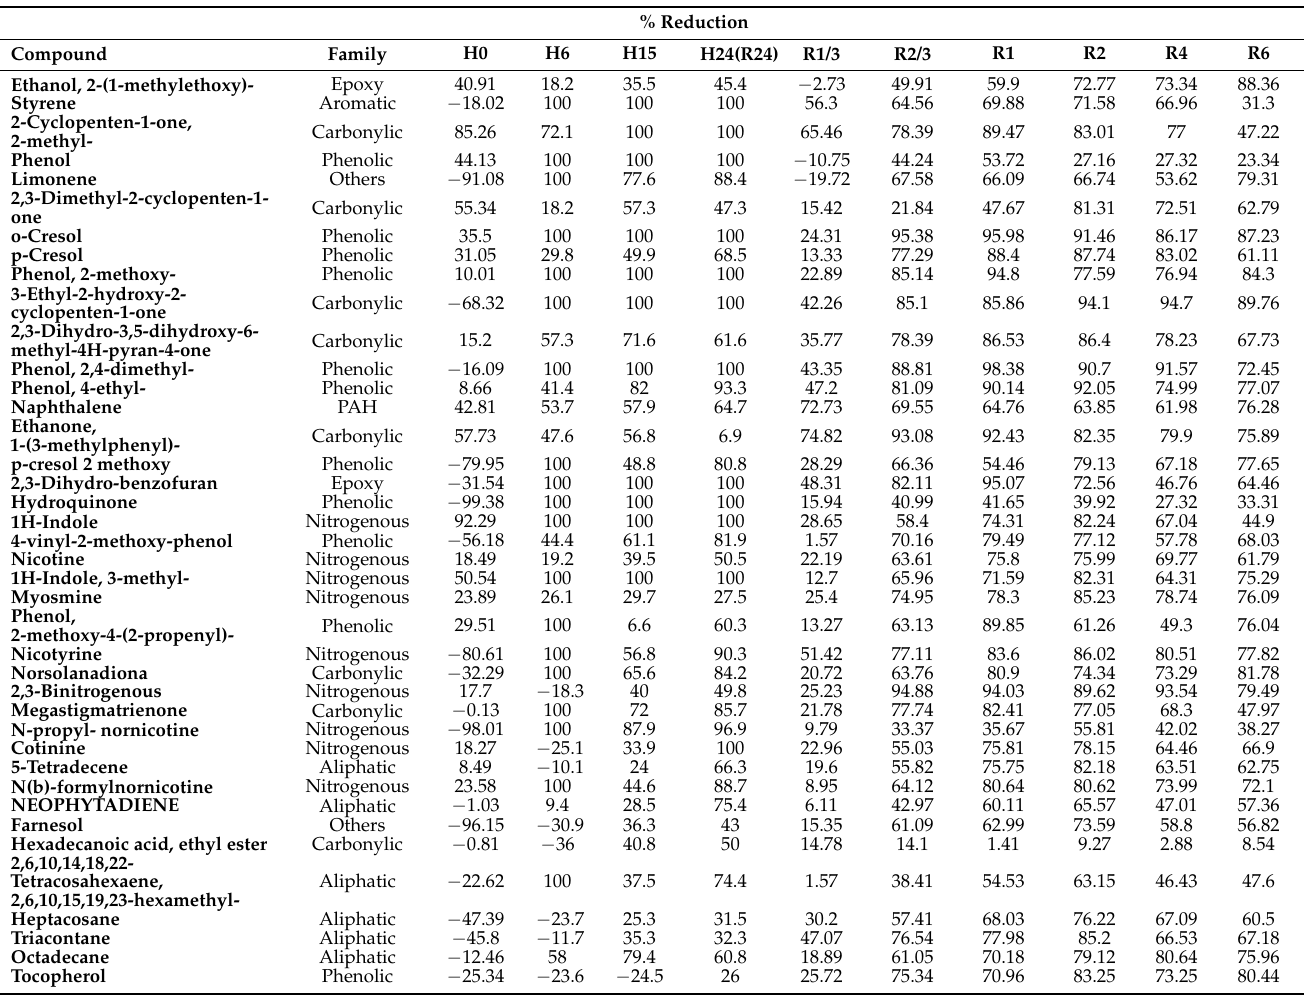
Figure 6. Reductions of the groups of compounds considered in the gas fraction vs. hydrothermal treatment time. Table 4. Yield reductions obtained in the condensed fraction for the different catalysts